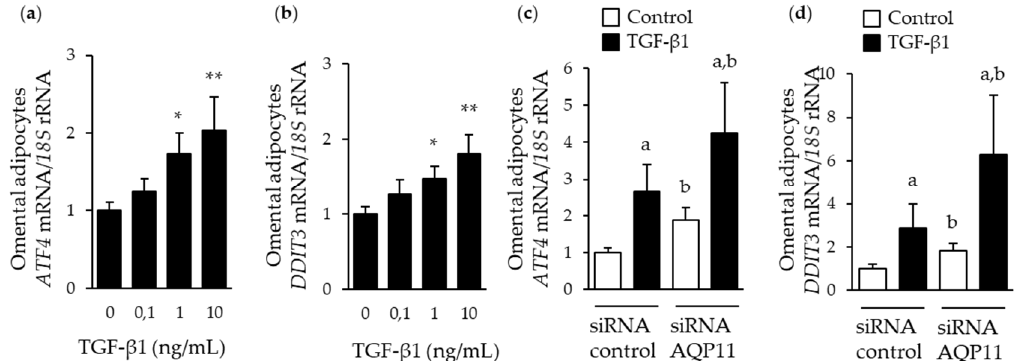
Figure 4. Impact of AQP11 gene silencing on basal and TGF- β 1-induced ER stress. Bar graphs show ATF4 and DDIT3 transcript levels in omental adipocytes after 24 h treatment with di ff erent concentrations of TGF- β 1 ( a and b ) as well as in AQP11 -silenced adipocytes after stimulation with TGF- β 1 10 ng / mL for 24 h ( c and d ). * p < 0.05, ** p < 0.01 vs. unstimulated cells; a p < 0.05 e ff ect of TGF- β 1 treatment; b p < 0.05 e ff ect of AQP11 gene silencing.